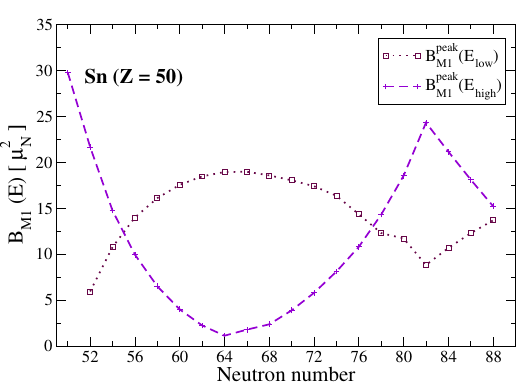
Figure 2. The M1 transition strengths for the two main peaks in even-even 100 − 140 Sn isotopes, where E lo w and E hi g h denote energies of the low- and high-energy